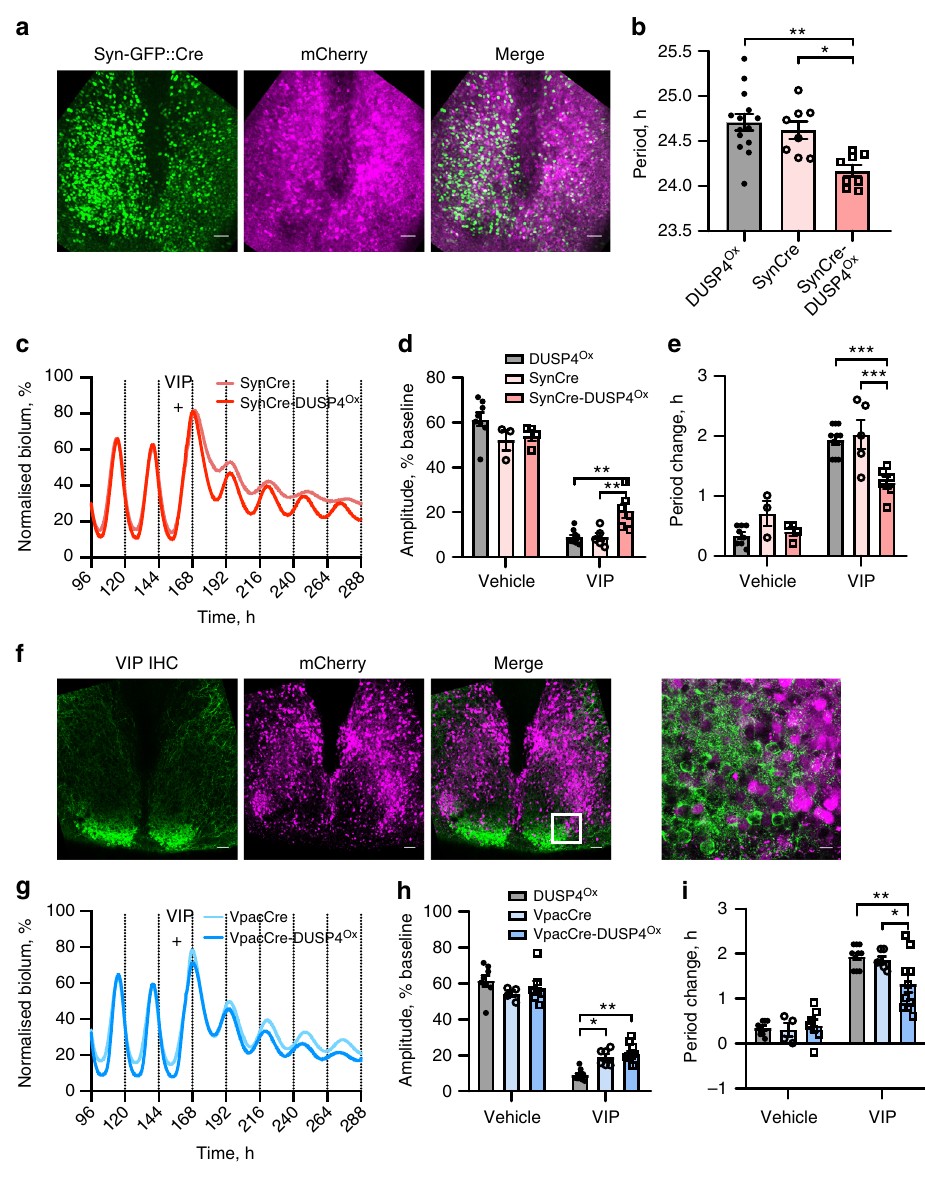
Fig. 8 Constitutive DUSP4 expression shortens circadian period and reduces the VIP response in SCN slices. a Representative confocal micrographs of an SCN slice transduced with hSyn.GFP::Cre AAV and Ef1a.DiO.mCherry-P2A-Dusp4 (SynCre-DUSP4 Ox ). b Group data for steady-state (pre-treatment) period of slices transduced as in a , along with individual AAV controls (mean ± SEM, one-way ANOVA, n = 14 for DUSP4 Ox group, n = 8 SynCre and SynCre- DUSP4 Ox ). c Representative PER2::LUC bioluminescence rhythms of SynCre and SynCre-DUSP4 Ox slices treated with 1 µ M VIP (marked by plus). d , e Group data for post-treatment relative amplitude ( d ), and period change ( e ) responses (mean ± SEM) of slices treated with vehicle or VIP at CT10. n as follows: DUSP4 Ox : veh, 8; VIP, 10; SynCre : veh, 3; VIP, 5; SynCre-DUSP4 Ox : veh, 4; VIP, 6. f Representative confocal micrographs of a Vpac2-Cre SCN slice transduced with Ef1a.DiO.mCherry-P2A-Dusp4 ( VpacCre-DUSP4 Ox ), immunostained for VIP to demonstrate separate populations of VIP and VPAC2 neurons (close up on right, white boxed region). g Representative PER2::LUC bioluminescence rhythms of VpacCre and VpacCre-DUSP4 Ox slices treated with 1 µ M VIP (marked by plus). h , i Group data for post-treatment relative amplitude ( h ), and period change ( i ) responses (mean ± SEM) of slices treated with vehicle